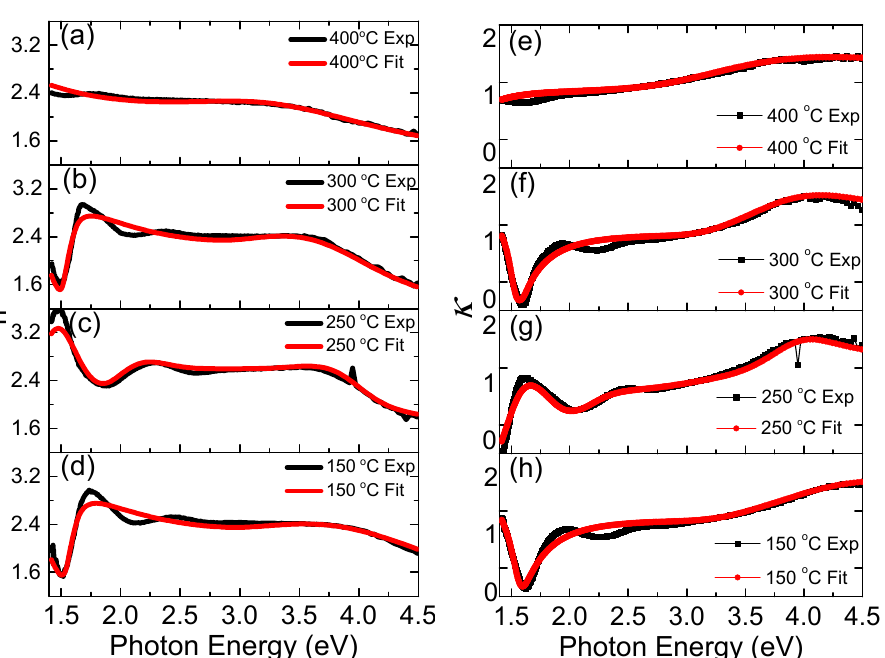
Figure 5. ( a – d ) Dependence of refractive index n and ( e – h ) extinction coefficient κ vs. photon energy of CdSe samples grown at different temperatures.